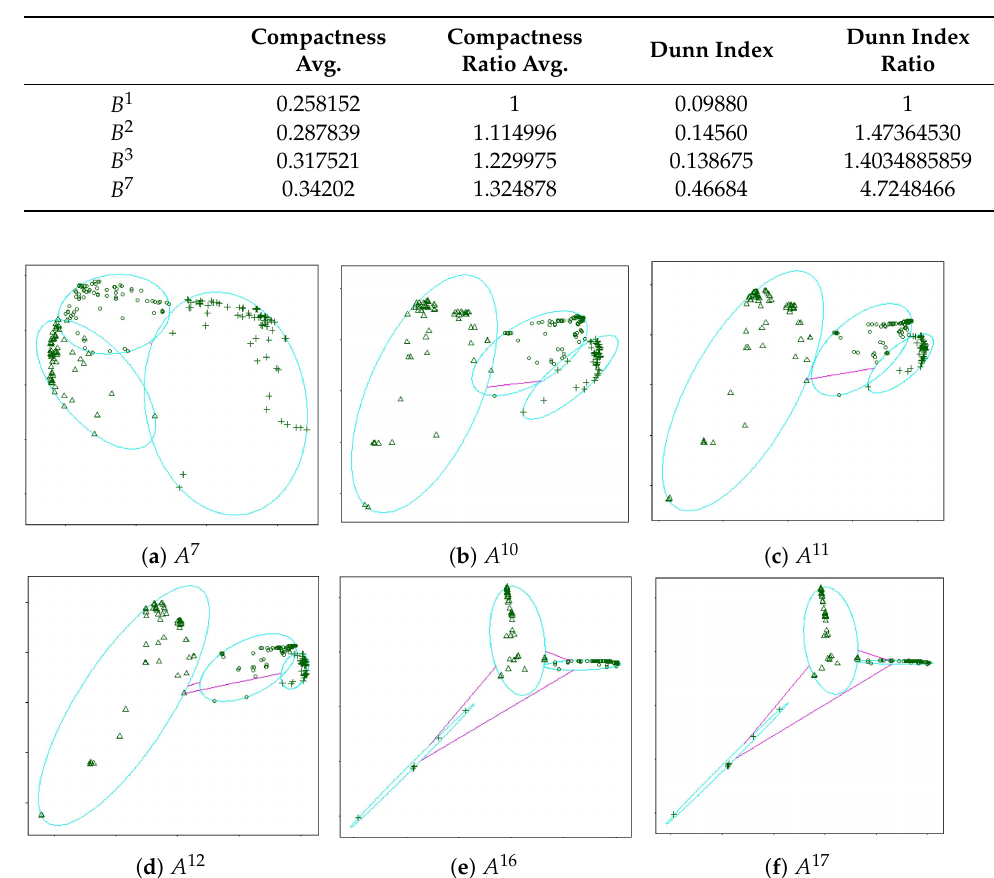
Figure 7. As the ultrametriciy of the Seed dataset increases, clusters become more distinct.